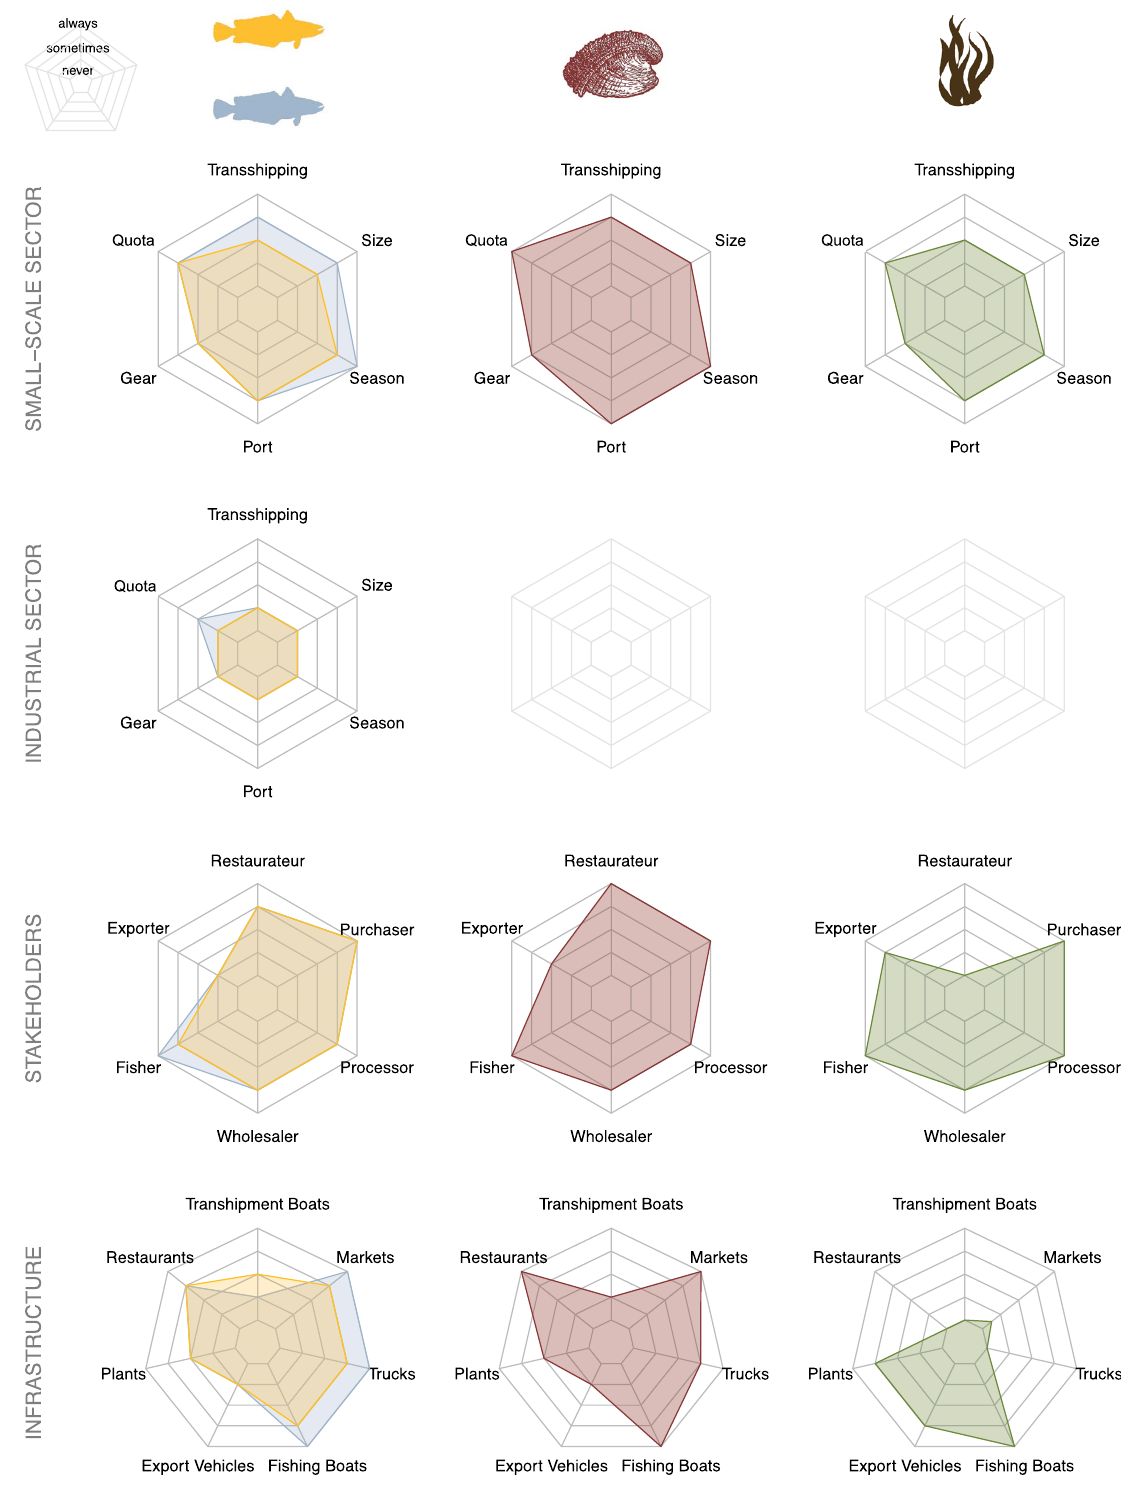
Figure 2. Fishery profiles of four Chilean fisheries: south Pacific hake (blue), southern hake (orange), Chilean abalone (red), and kelp (green). Predicted median estimates of the level of illegality in industrial sector activity, small-scale sector activity, stakeholders, and infrastructure. Industrial fishing does not exist for Chilean abalone and kelp. Predicted medians are from a Bayesian cumulative multinomial logit model for each of the four focal fisheries. The entire posterior distributions of the model results are shown in Figs.